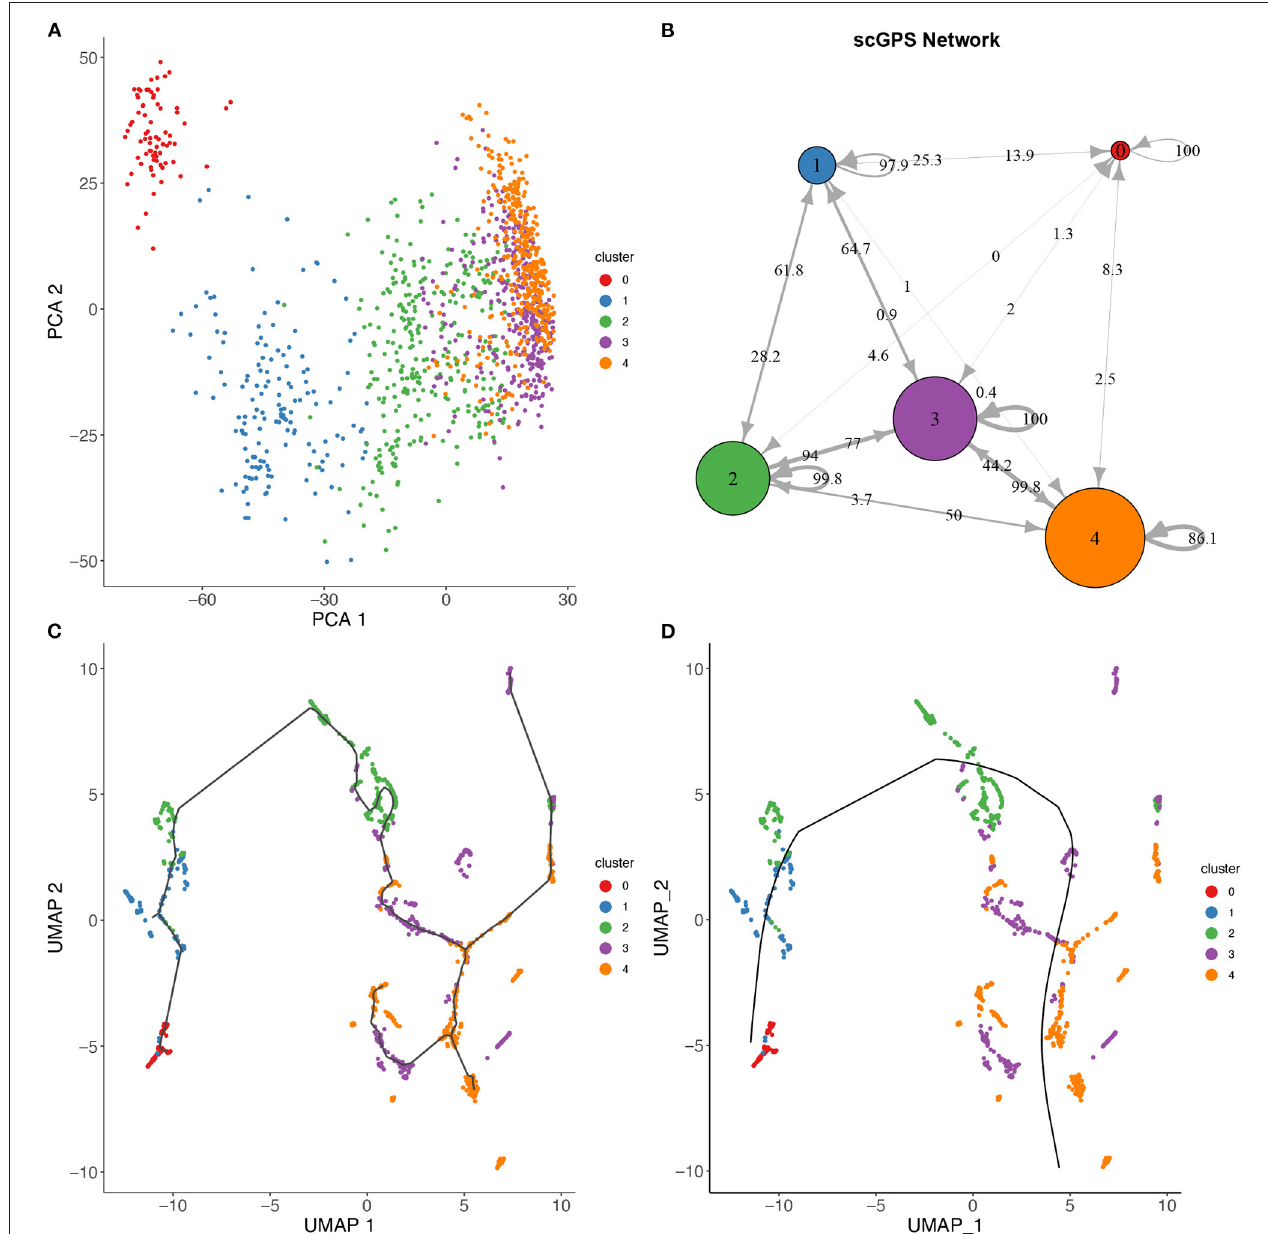
FIGURE 4 | scGPS trajectory comparisons with methods Slingshot and Monocole on the full-length total RNA sequencing dataset from Petropoulos et al. (2016), processed by Saelens et al. (2019). (A) PCA dimensionality reduction of the dataset. The data is labelled with timing information for the cells which were collected at 5 time points. (B) scGPS trajectory analysis. Arrows show direction and numbers show transitioning scores. For example, number 50 on the arrow from cluster 2–4 indicates a score of 50% total cells transitioning from 2 to 4. (C) Monocole trajectory graph. (D) Slingshot trajectory graph. The black, smoothed curve shows predicted linage, connecting clusters represented by coloured